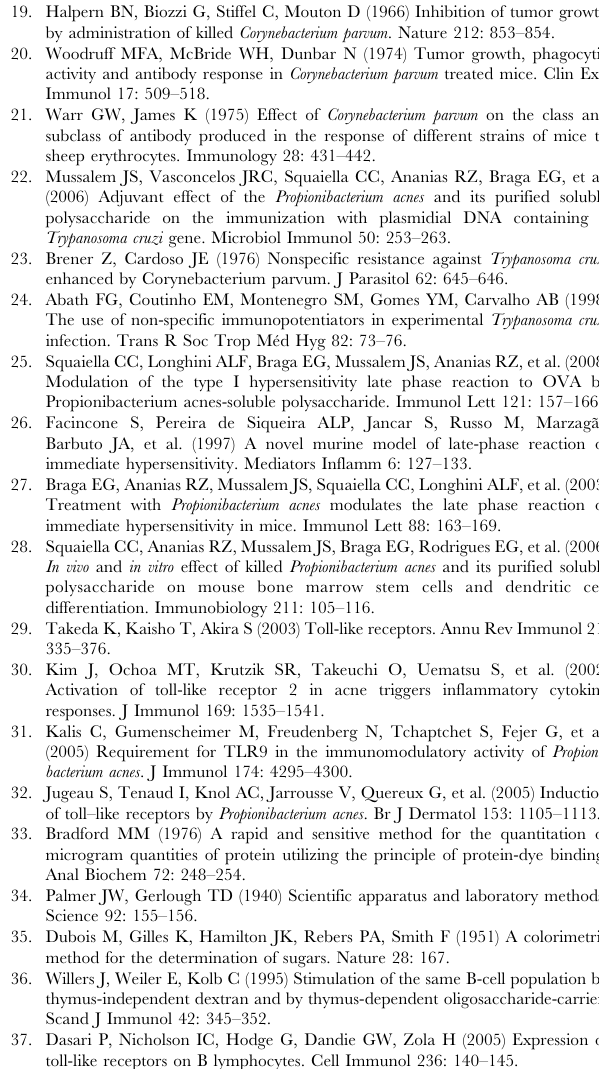
Figure S3 Analysis of the activation status of B-1a lymphocytes in vitro . The non-adherent cell population from the P. acnes -, PS-, or saline- (control group) treated mice was analyzed after 5 days in culture to determine TLR, co-stimulatory molecule, MHC II and cytokine expression by B-1a lymphocytes. The cells were stained with mAbs to determine the absolute number (A to C) of B-1a lymphocytes expressing the studied molecules and the mean fluorescence intensity (MFI) of each marker (D to F). The absolute cell number and MFI are the means of two independent experiments with similar results. * p , 0.05 between the control and treated groups. # p , 0.05 between the P. acnes and PS treated groups. Figure S4 Analysis of the activation status of B-1c lymphocytes in vitro . The non-adherent cell population from the P. acnes -, PS-, or saline- (control group) treated mice was analyzed after 5 days in culture to determine TLR,